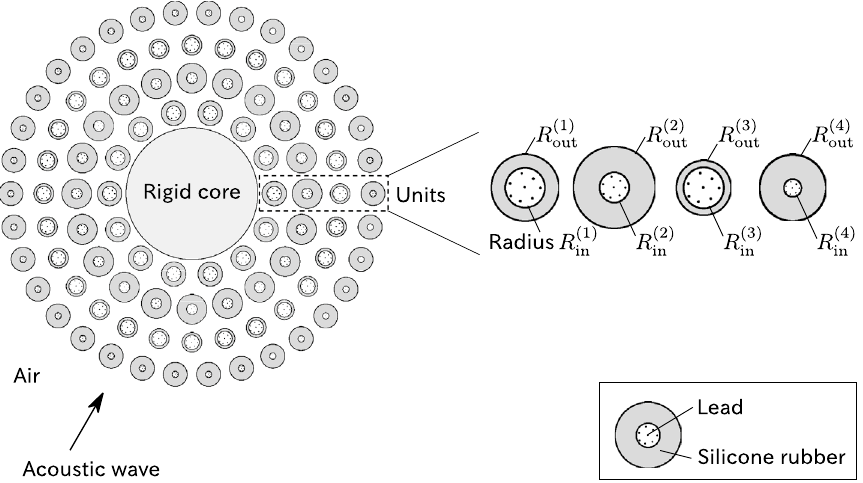
Figure 1. Rigid-material core covered with rubber-lead rods. The number of rods in each layer, from innermost to outermost, are 14, 20, 28, and 34. The materials are placed in air and illuminated by an incident acoustic wave. ( 1 ) , R ( 4 ) , R ( 4 ) , R ( 3 ) , R ( 3 ) , R ( 2 ) , R ( 2 ) , R ( 1 ) The radii R out out out out in are optimized by the proposed method. The core is placed at in in in the origin. The centers of the rods are located at (1.25 R , 0), (1.75 R , 0), (2.25 R , 0), and (2.75 R , 0) (from innermost to outermost), where R is the radius of the